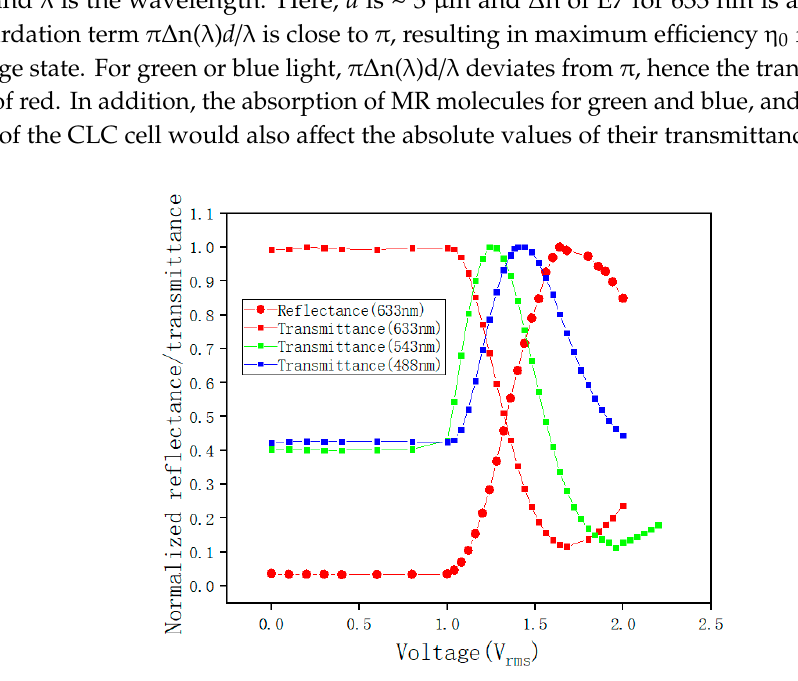
Figure 6. GP lens ( a ) optical micrograph under crossed polarizers; ( b ) response time; and ( c ) voltage- dependent first-order diffraction efficiency.